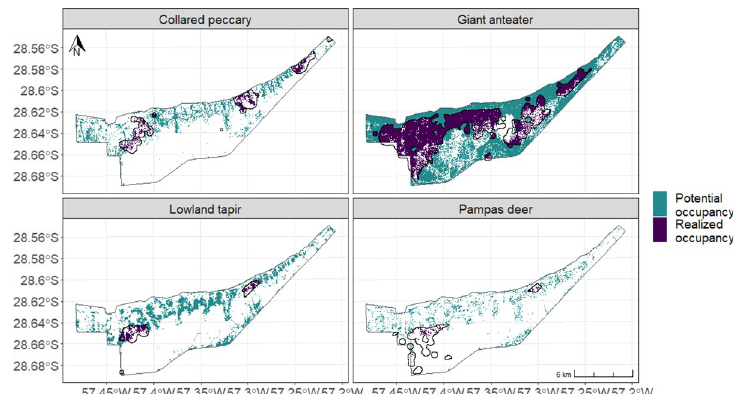
Fig 4. Realized and potential occupancy of reintroduced species. Predicted probability of presence inside and beyond current species range for giant anteater, pampas deer, lowland tapir and collared peccary, in our study site. Realized occupancy of reintroduced species was defined as predicted probability of presence of more than 0.5 inside the current species range, and potential occupancy of reintroduced species was defined as predicted probability of presence of more than 0.5 beyond the current species range. The areas delimitated in black are the species ranges of each species.